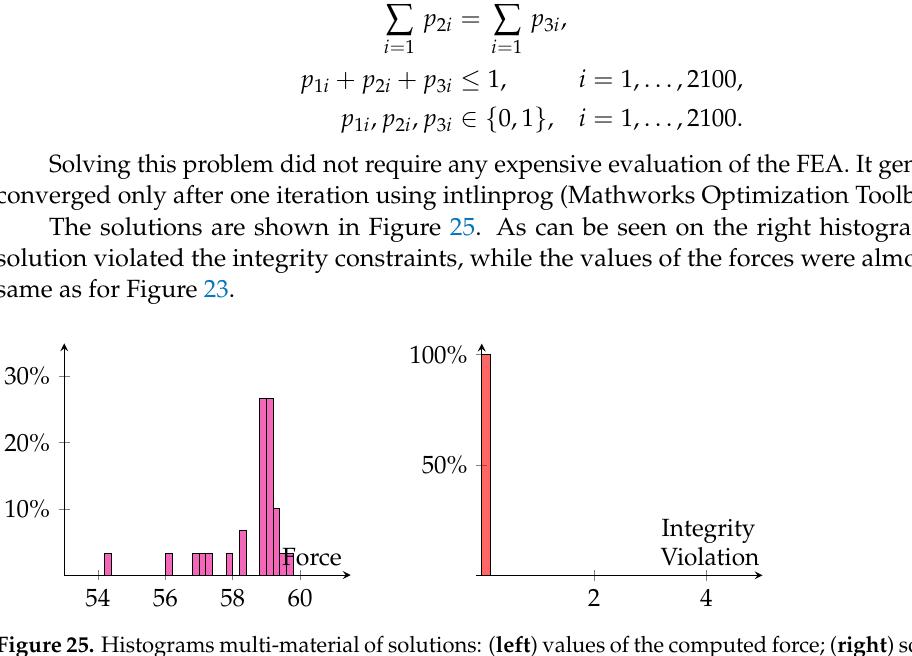
Figure 25. Histograms multi-material of solutions: ( left ) values of the computed force; ( right ) solution integrity